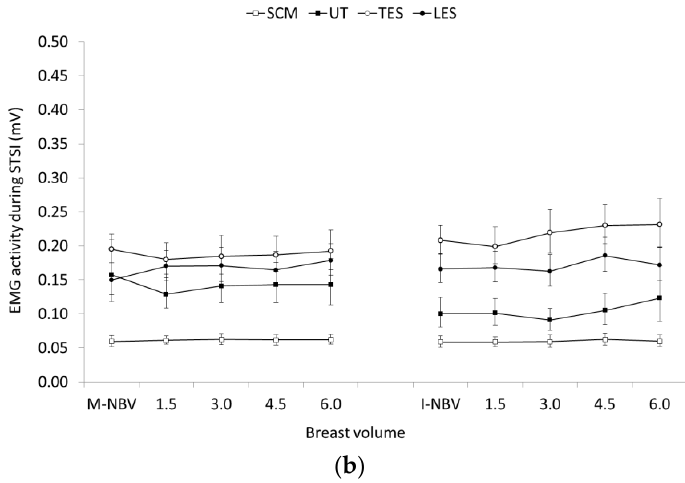
Figure 4. ( a ) Stand-to-Sit (STSI); ( b ) Geometric means and confidence intervals (error bars) of the sternocleidomastoid (SCM), upper trapezius (UT), and thoracic and lumbar erector spinae (TES and LES) EMG activity in females with minimal and ideal natural breast volume (M-NBV, I-NBV) as well as with increased NBV by 1.5-, 3.0-, 4.5- and 6.0-times during STSI.